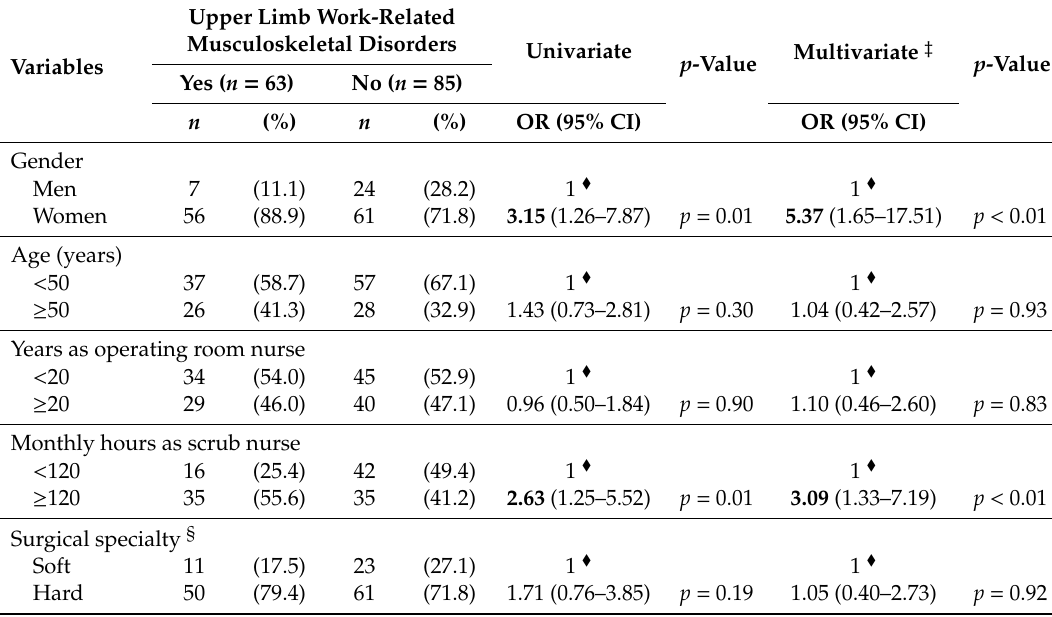
Table 3. Odds ratios (ORs) and 95% confidence intervals (CIs) for disabilities of the arm, shoulder and hand (DASH) score according to socio-demographic factors and job characteristics among 148 operating room nurses. Italy,